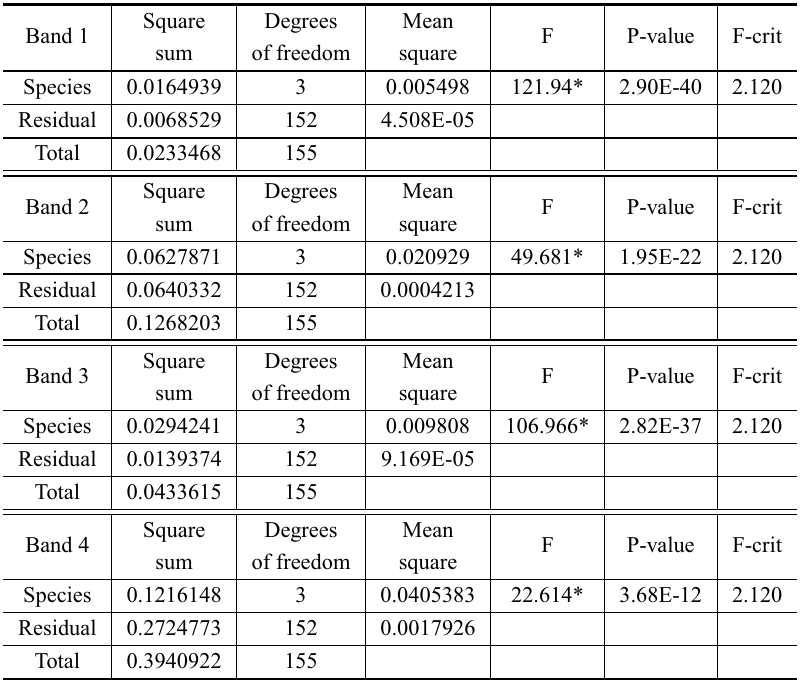
Results of ANOVA application on all species and spectral bands.